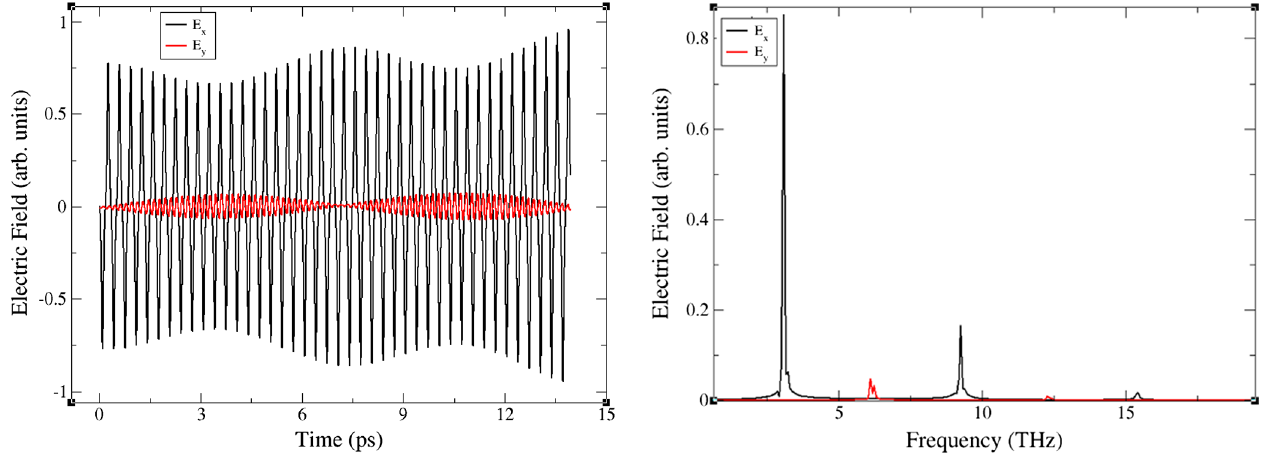
FIG. 4. Temporal profile and spectrum of radiation emitted by an electron injected off-axis of an undulator with K ¼ 0 . 5 .